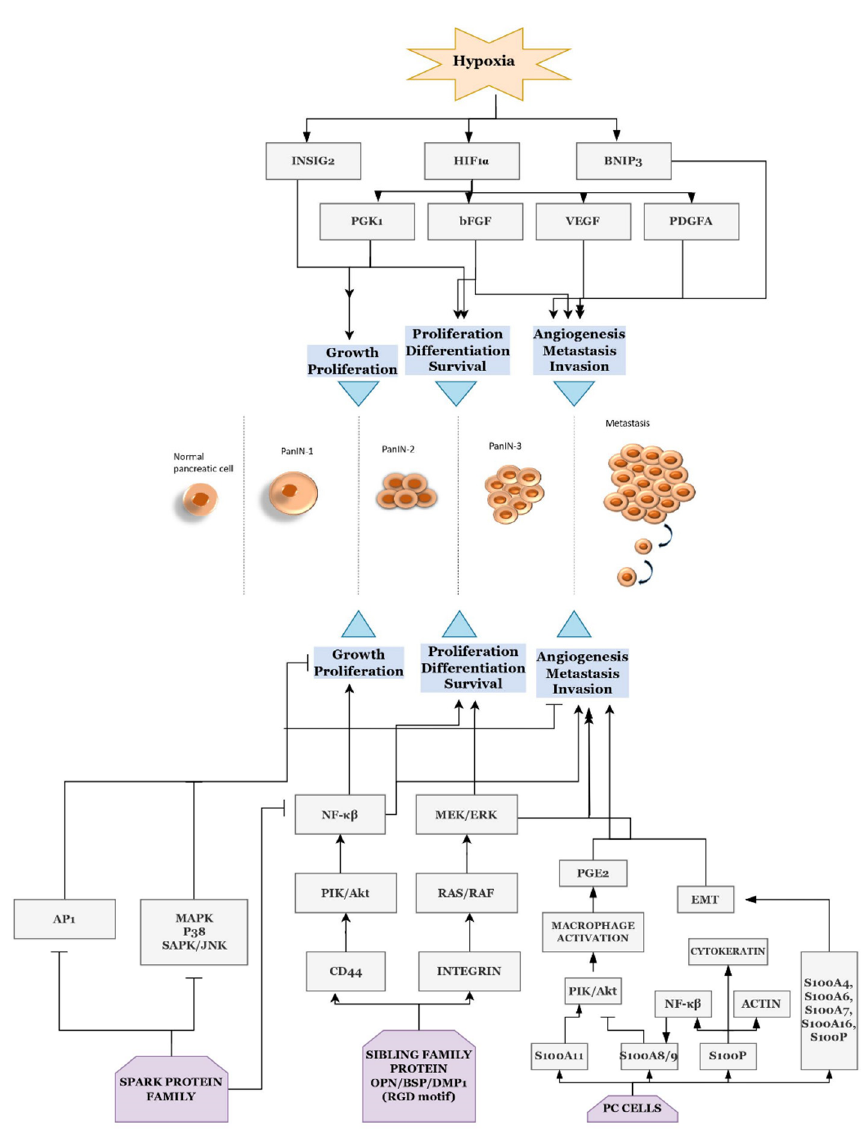
Figure 3. Schematic diagram of the possible mechanism of tumorigenesis of PC by SIBLING protein family, SPARC protein family, and S100 protein family, and proteins stimulated during hypoxia condition resulting in cancer development. SIBLING, Small Integrin Binding Ligand N-linked Glycoprotein; OPN, Osteopontin; BSP, Bone SialoProtein; DMP1, Dentin Matrix Protein I; CD44, Cluster of Differentiation 44; RAS/RAF, RAt Sarcoma/Rapidly Accelerated Fibrosarcoma GTP binding proteins; MEK/ERK, Mitogen-Activated protein kinases/Extracellular signal-regulated protein kinases; PI3K/Akt, Phosphatidylinositol 3-Kinase/Ser/Thr Protein kinase; NF- κβ , Nuclear factor Kappa light-chain-enhancer of activated B cells; MAPK, Mitogen-Activated Protein Kinase; SAPK/JNK, Stress-activated protein kinases/c-Jun N-terminal Kinases; AP-1, Activating protein-1; PC cells, Pancreatic Cancer cells; PGE2, Prostaglandin E2; EMT, Epithelial to Mesenchymal Transition; INSIG2, Insulin-induced gene 2; HIF1 α , Hypoxia-induced factor-1 α ; BNIP3, BCL2 interacting protein 3; PGK1, phosphoglycerate kinase 1; bFGF, basic fibroblast growth factor; VEGF, vascular endothelial growth factor; PDGFA, Platelet-derived growth